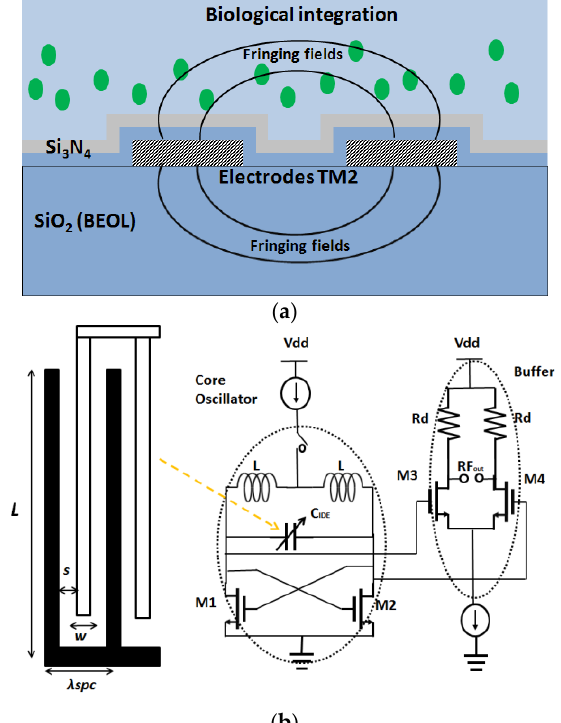
Figure 8. ( a ) Capacitive sensing scheme. The electrodes of the capacitor are fabricated on top metal of the BiCMOS stack; ( b ) The interdigitated capacitor is a part of the cross coupled oscillator. One of the main applications of the established CMOS biosensor is immunosensing [59]. The immunosensing principle functionality has been demonstrated with a model antibody, creatinine.